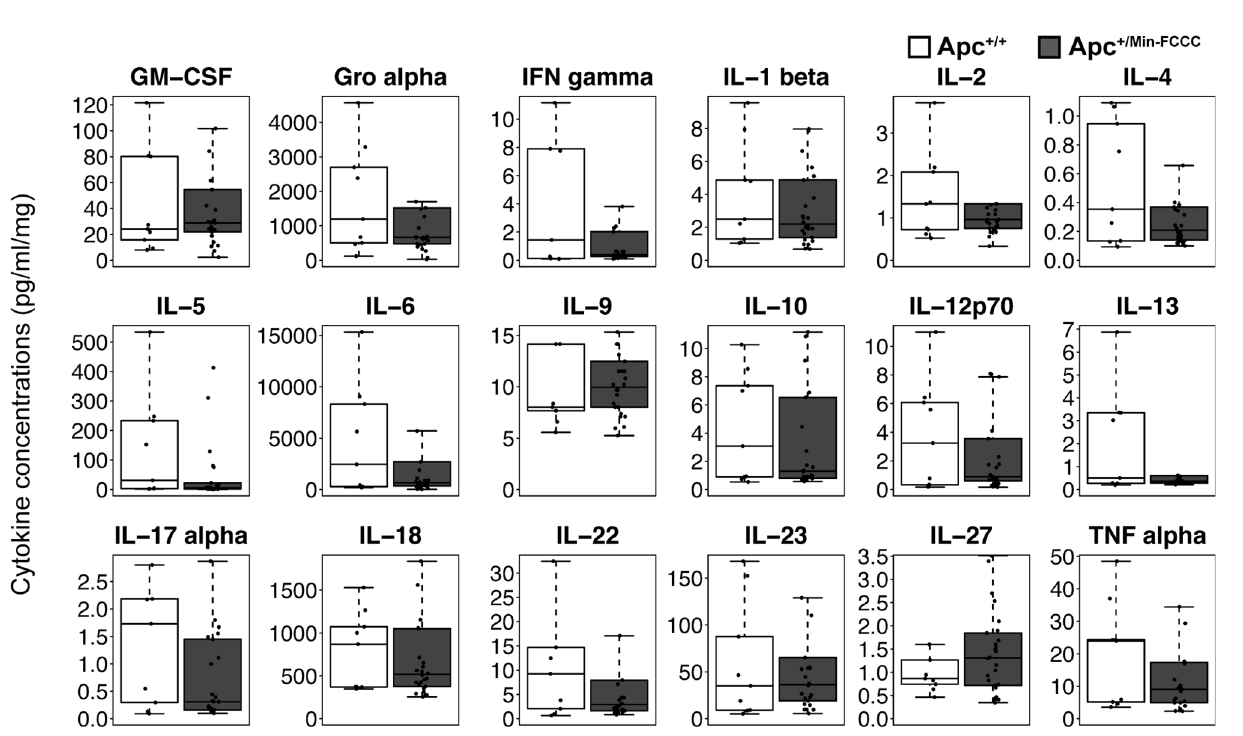
FIGURE 4 | Cytokines involved in Th1, Th2, Th9, and Th17 signaling in colon tissues from Apc +/Min-FCCC and Apc +/+-FCCC wild type mice. Boxplots depict cytokine concentration in media (pg/ml) normalized to mass of colon tissue (mg) from Apc +/+-FCCC wild type mice (white; n=9) and Apc +/Min-FCCC mice (gray; n=26). Outlying data points (>3rd quartile + 1.5 x interquartile range) are omitted; all data points are shown in Supplemental Figure 4 . Median fold change = 0.2 – 1.5; Mann Whitney p ≥ 0.17; p=1.00 after adjusting for multiple